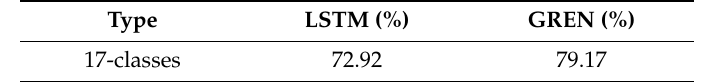
Table 4. Comparison results between LSTM and GREN networks based on the MSRA